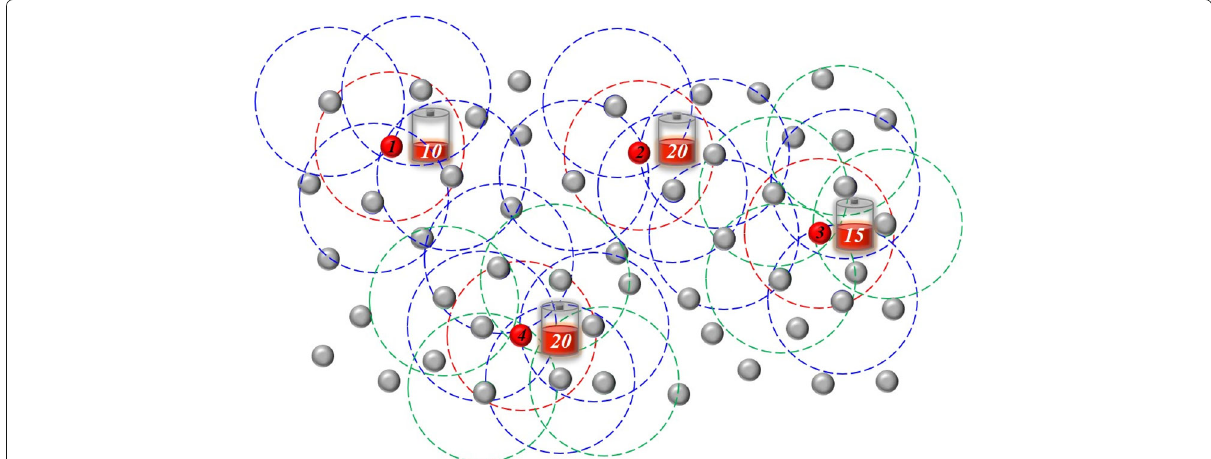
Fig. 2 Illustration of the problem considering coverage and remaining energy of